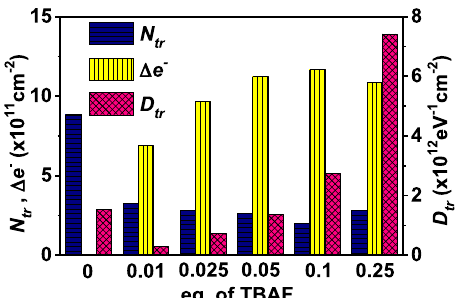
Fig. 4 Additional free electrons generated by addition of TBAF ( Δ e + ), interface trap density ( N tr ) and trap concentration per energy unit ( D tr ) of transistors based on un-doped and doped P(NDI2OD-T2) as a function of equivalents of